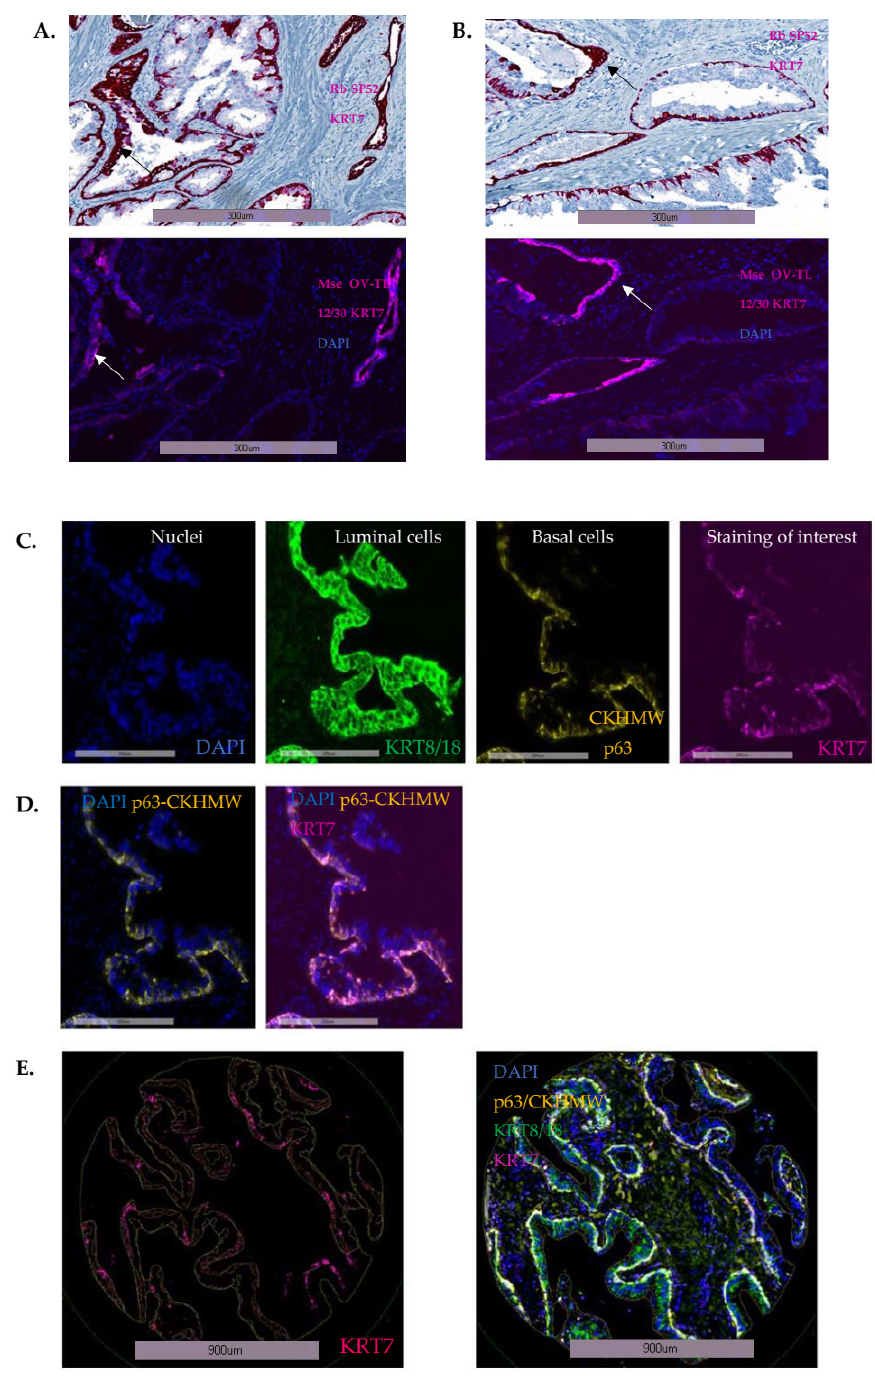
Figure 3. Comparison of KRT7 staining using two different antibodies and two different staining strategies (IF/IHC) on serial slides of radical prostatectomies from localized PC, and details of the digital image protocol optimized for multiplex staining and biomarker analyses. ( A , B ) Concordance of KRT7 staining between the rabbit SP52 staining in IHC and the mouse OV-TL 12/30 staining in IF, in two separate areas from tissue section of radical prostatectomies. Supra-basal staining is indicated with arrows. ( C ) Multiplex staining of TMA cores discriminates nuclei (DAPI, blue), luminal cells (KRT8/18, FITC-488 green), basal cells (p63/CKHMW, TRITC-546 yellow), and the studied biomarker KRT7 (mouse OV-TL 12/30 KRT7, Cy7 pink) in benign peri-tumoral glands, ( E ) with superimposed images corresponding to merged co-staining. ( D ) p63 and KRT7 positively stained in basal cells without cross-over